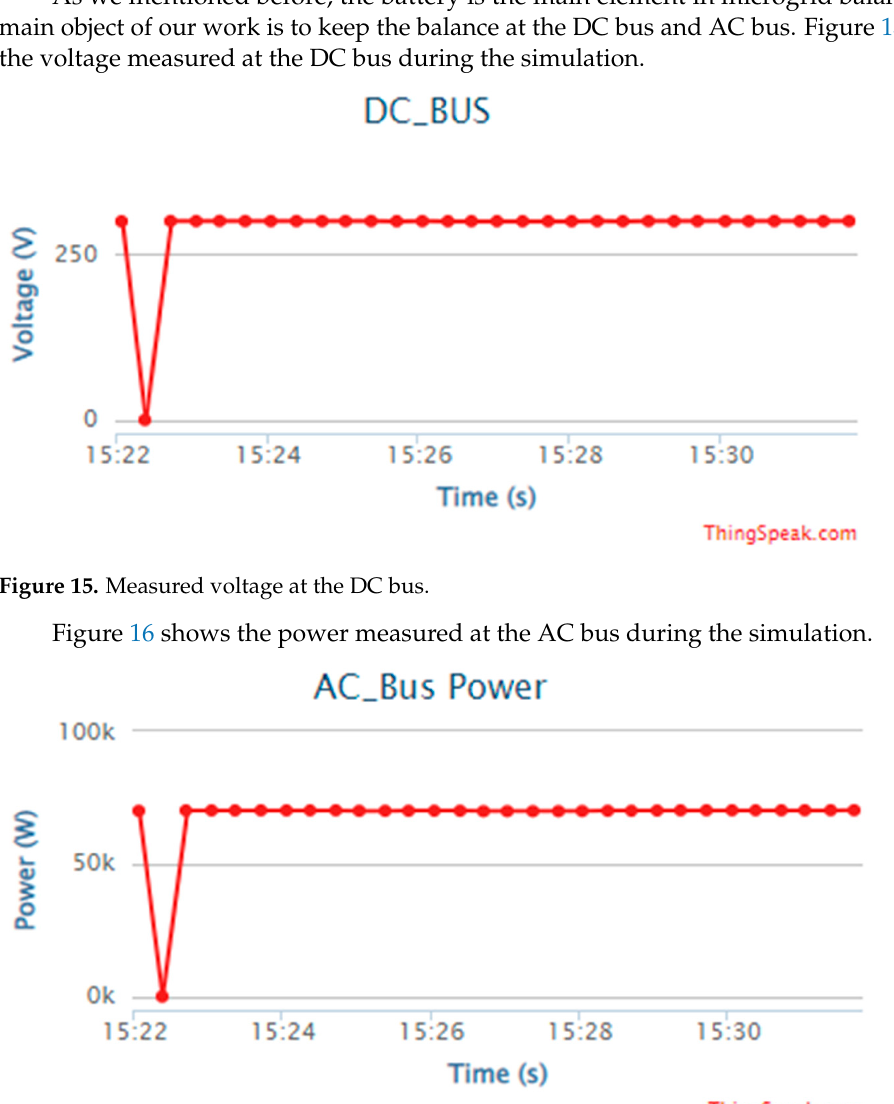
Figure 14. Variation in SOC (%).